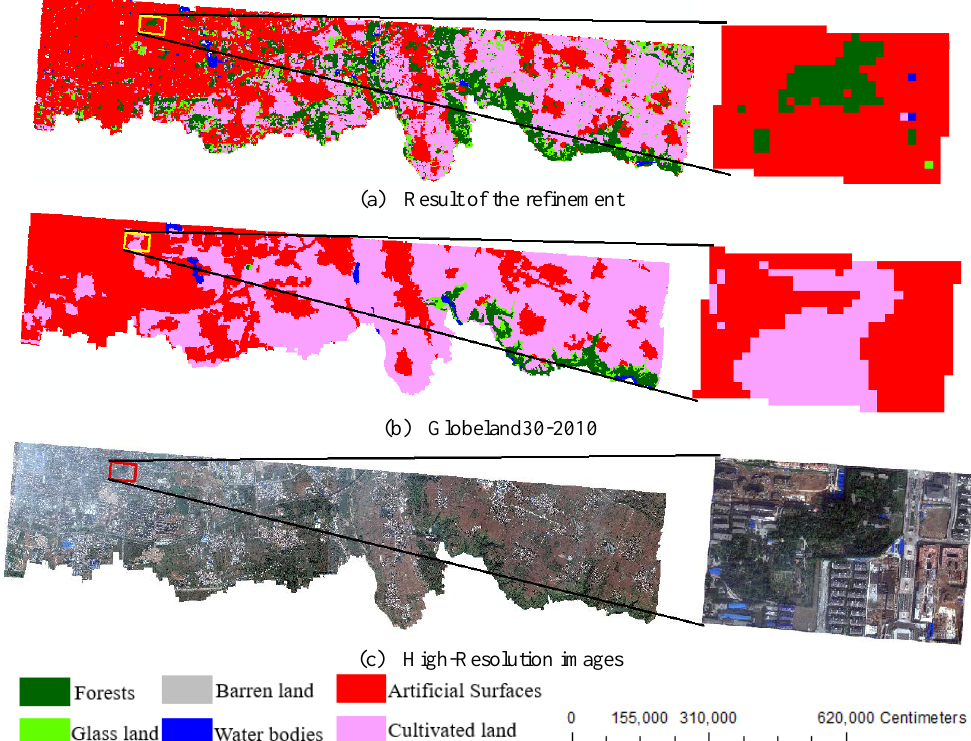
Figure 5. Compare the result of refinement and